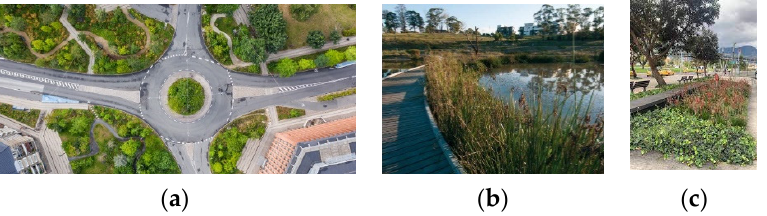
Figure 1. Examples in Copenhagen ( a ) https://www.sla.dk/en/projects/bryggervangen-sankt-